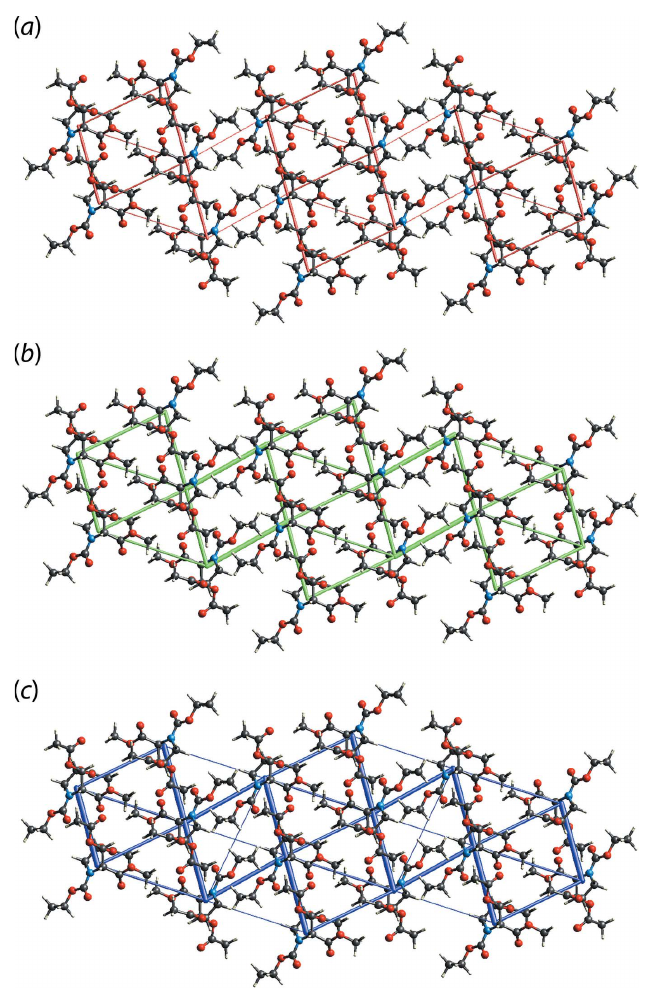
Figure 7 Perspective views of the energy frameworks calculated for (II) and viewed down the b axis showing ( a ) electrostatic potential force, ( b ) dispersion force and ( c ) total energy. The radii of the cylinders are proportional to the relative magnitudes of the corresponding energies and were adjusted to the same scale factor of 55 with a cut-off value of